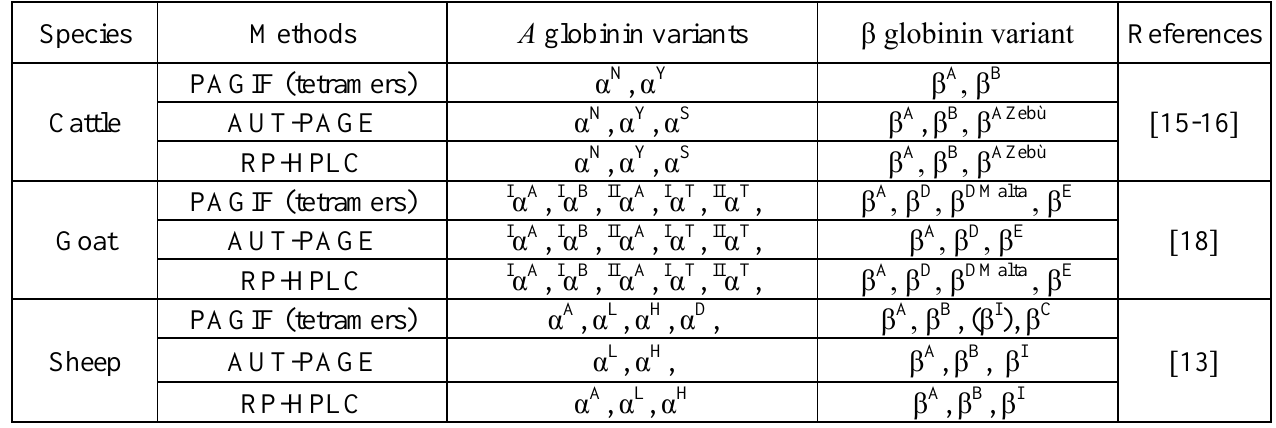
Table 5. Main methods for detecting relevant Hb and globin variants found in ruminant Mediterranean populations.